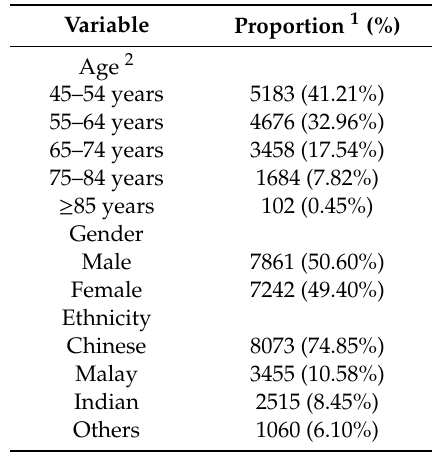
Table 1. Demographic distribution of the